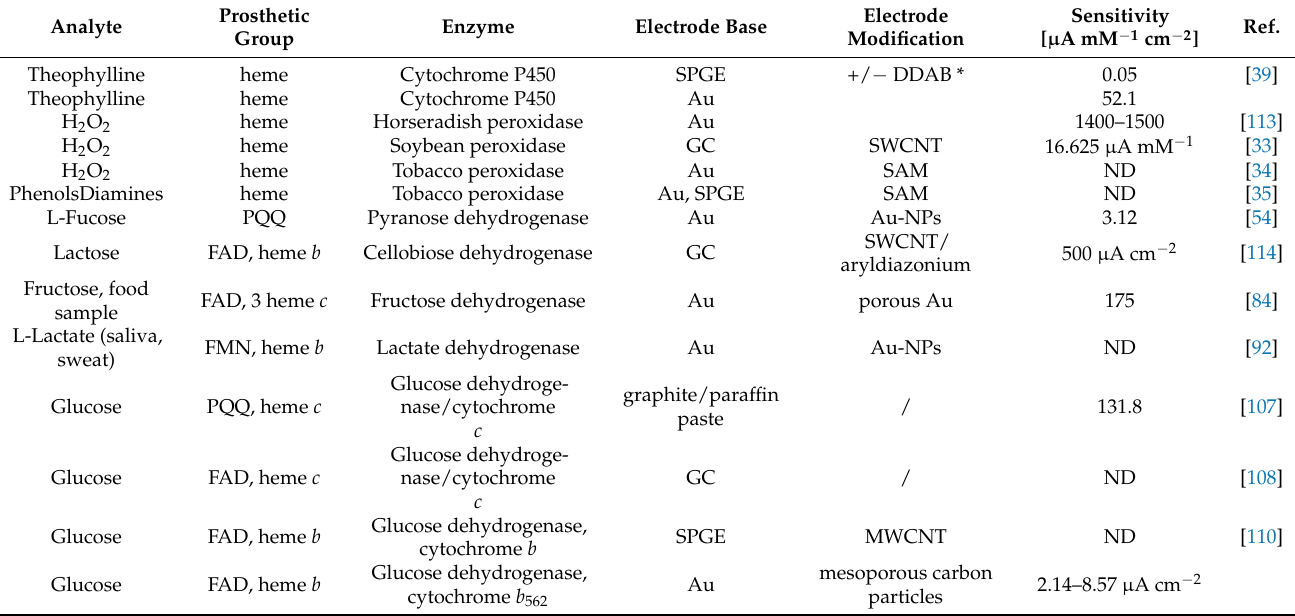
Table 1. Various analytes detected by DET-capable enzymes in 3rd generation biosensors.